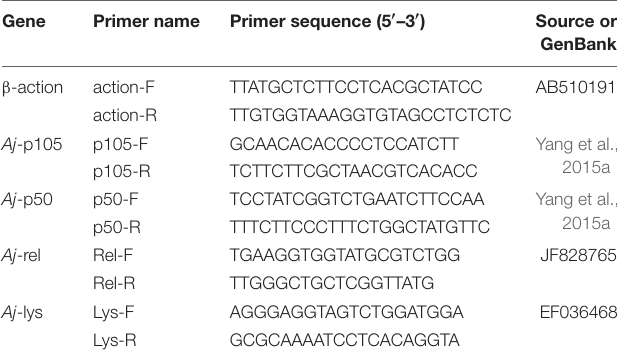
TABLE 1 | Primer sequences of internal reference and target genes for real-time